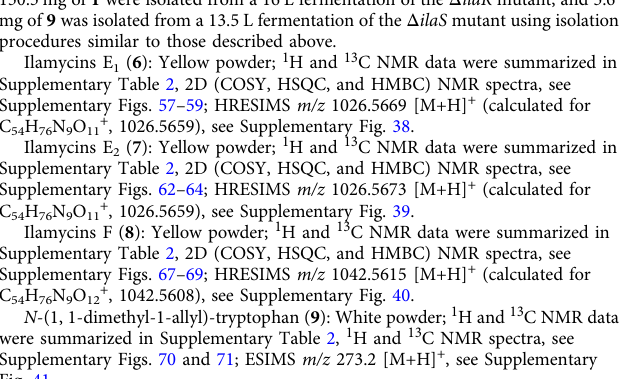
Supplementary Table 5. Each of the apramycin resistance gene cassettes was then introduced into E. coli BW25113/pIJ790/201E, BW25113/pIJ790/23D, or BW25113/pIJ790/47H by electroporation depending on the location of the gene to be inactivated. Correct mutants were veri fi ed by PCR ampli fi cation and restriction enzyme digestion of the mutant cosmid. The correctly mutated cosmids were then introduced into E. coli ET12567/pUZ8002 for conjugation with S. atratus SCSIO ZH16. The conjugation processes were carried out as described previously 20 , and double crossover mutant strains possessing the kanamycin S and apramycin R phenotypes were con fi rmed by PCR using primers listed in Supplementary Table 5. Finally, 22 S. atratus SCSIO ZH16 genetic mutants ( Δ ilaCDEFGH , Δ ilaLMNO , Δ ilaRS , Δ orf( + 1) to Δ orf( + 5) , and Δ orf(-2) to Δ orf(-6) ) were successfully con- structed. The PCR veri fi cation of the mutants were shown in Supplementary Figs. 5 – 26. The HPLC analysis of the metabolite pro fi les of 10 mutants ( Δ orf( + 1) to Δ orf( + 5) , and Δ orf(-2) to Δ orf(-6) ) showed that they were not necessary for the biosynthesis of ilamycins as they did not produce an obvious in fl uence on ilamycin generation (Supplementary Fig. 27). Silico analysis of the domains in IlaE and IlaM . To investigate the possible mechanisms underlying the unique modules of IlaE, multiple sequence alignments were carried out for each type of domain. The sequence alignments results revealed that the conserved motifs in KS 1 (Supplementary Fig. 28), KR 2 , KR 3 (Supple- mentary Fig. 29), and ER 3 (Supplementary Fig. 30) were different from the iden- ti fi ed conserved ones 49 – 56 . The substrates speci fi cities of AT domain were predicted based on the conserved sequence of GHSIGE … R … HAFH (Supplementary Fig. 31). Silico analysis of indicted that IlaM shared the same active sites with other nitric oxide synthase originate from the human or murine, but clustered in dif- ferent clades (Supplementary Fig. 32). IlaM also shows sequence homology to TxtD (52% identity) from Streptomyces turgidiscabies car8 (Supplementary Fig. 33), which has been proposed to generate nitric oxide from L -Arg for further use in L -Trp 4-nitration catalyzed by the cytochrome P450, TxtE, in the thaxtomin pathway 37, 38 . Metabolite analysis of wild-type and mutant strains . To analyze the metabolites of each mutant, the mutant strains were inoculated in a 250-mL fl ask fi lled with 50- mL Am2ab medium and grown at 30 °C on a rotary shaker at 200 rpm for 7 days with the wild-type as a control. The fermentation was extracted with an equal volume of butanone and processed using the aforementioned method. The dried extracts of the fermentation products were re-suspended in 1-mL methanol and were centrifuged for 10 min at 14000rpm before HPLC analysis. HPLC analysis was carried out using a reversed phase column SB-C18, 5 μ m, 4.6× 150 mm (Agilent) with UV detection at 210, 285, and 352 nm under the following program: solvent system (solvent A, 15% acetonitrile in water supplemented with 0.1% acetic acid; solvent B, 85% acetonitrile in water supplemented with 0.1% acetic acid); 20% B to 80% B (linear gradient, 0 – 20 min), 80% B to 100% B (linear gradient, 20 – 21.5 min), 100% B (21.5 – 27.0 min), 100% B to 0% B (27.0 – 27.1 min), 0% B (27.1 – 30.0 min); fl ow rate was set at 1mL min − 1 . Isotopic labeling experiments . To elucidate the biosynthetic origin of the L -AHA unit, isotopic labeling experiments were carried out with cultures of the S . atratus SCSIO ZH16. Three 13 C-labled compounds, [1- 13 C] sodium acetate, [2- 13 C] sodium acetate, and [1, 2- 13 C] sodium acetate, were used for the feeding experi- ments. The 13 C-labeled agent was dissolved in ddH 2 O at a concentration of 500 mg mL − 1 as stock solution. The stock solution was sterilized via fi ltration, and then individually supplied into 1 L production cultures (Am3 medium) at 60, 72, and 84 h with the volume of 0.5, 1, and 0.5 mL, respectively. After cultivation at 220 rpm and 30 °C for 7 days, the cultures were harvested and extracted. The representative product, 13 C-labled ilamycin B 2 , was puri fi ed from the organic extract. Precursor feeding experiments . A portion of mycelium and spores (1cm 2 ) of the mutant strain was inoculated into a 250-mL fl ask with 50 mL of Am3 medium as described above at 30 °C and 200 rpm for 60 h. Synthesized L (D)-AHA, 2,4-HDA, and 4-HA were dissolved in acidi fi ed water, neutralized with 1N NaOH to pH 7.0, and sterilized via fi ltration. The sterilized L (D)-AHA and 4-HA were supplied into the culture of the Δ ilaD mutant, and the L (D)-AHA, 2,4-HDA, and 4-HA were individually fed to cultures of Δ ilaE mutant to achieve a fi nal concentration of 0.5 mM. Following incubation at 30°C and 200 rpm for 7 days, the cultures were each harvested and extracted with butanone, evaporated to dryness, and dissolved in MeOH for HPLC analysis (Fig. 2, x – xv). The feeding procedures of 3-nitro-L- tyrosine to Δ ilaM or Δ ilaN mutants were similarly conducted. The 3-nitro-L- tyrosine precursor was dissolved in acidi fi ed water, neutralized with 1 N NaOH to pH 7.0 and sterilized via fi ltration, and was then individually supplemented into the cultures of Δ ilaM or Δ ilaN mutants (Fig. 2, xviii and xix). Cytotoxicity assays . Compounds 1 – 8 were evaluated for cytotoxicity using HeLa, HepG2, A549, CNE2, and MCF7 cell lines using a previously reported MTT method 57 . The L02 and Huvec-12 cell lines were used as normal cell line controls. All these cell lines were obtained from American Type Culture Collection (ATCC) and cultured according to ATCC recommendations. Cell lines were checked for mycoplasma and pro fi led via short tandem repeat pro fi ling to con fi rm